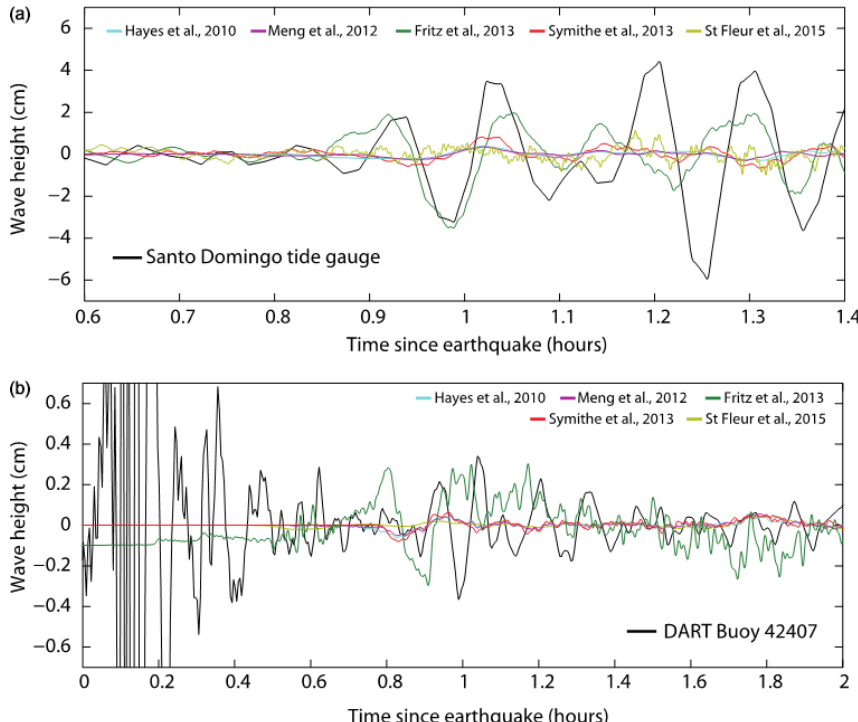
Figure 3. Comparison between observed and simulated water heights at the Santo Domingo tide gauge (a) and at DART buoy 42407 (b) . Their locations are provided in Fig. 1. The high-amplitude signal on the DART record before ∼ 0 . 7h is seismic surface waves.